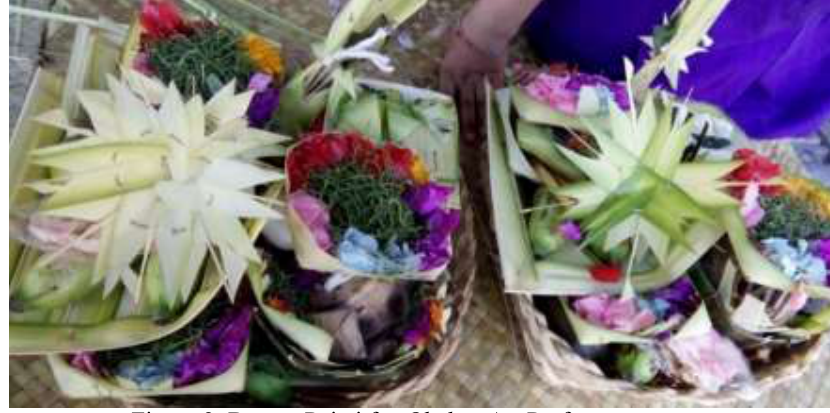
Figure 2. Banten Pejati for Okokan Art Performance